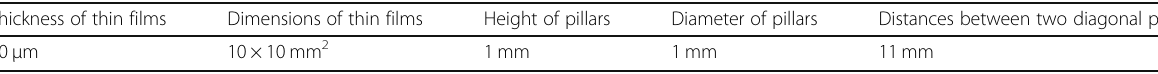
Table 1 Geometric parameters of the bilayer sensor Thickness of thin films Dimensions of thin films Height of